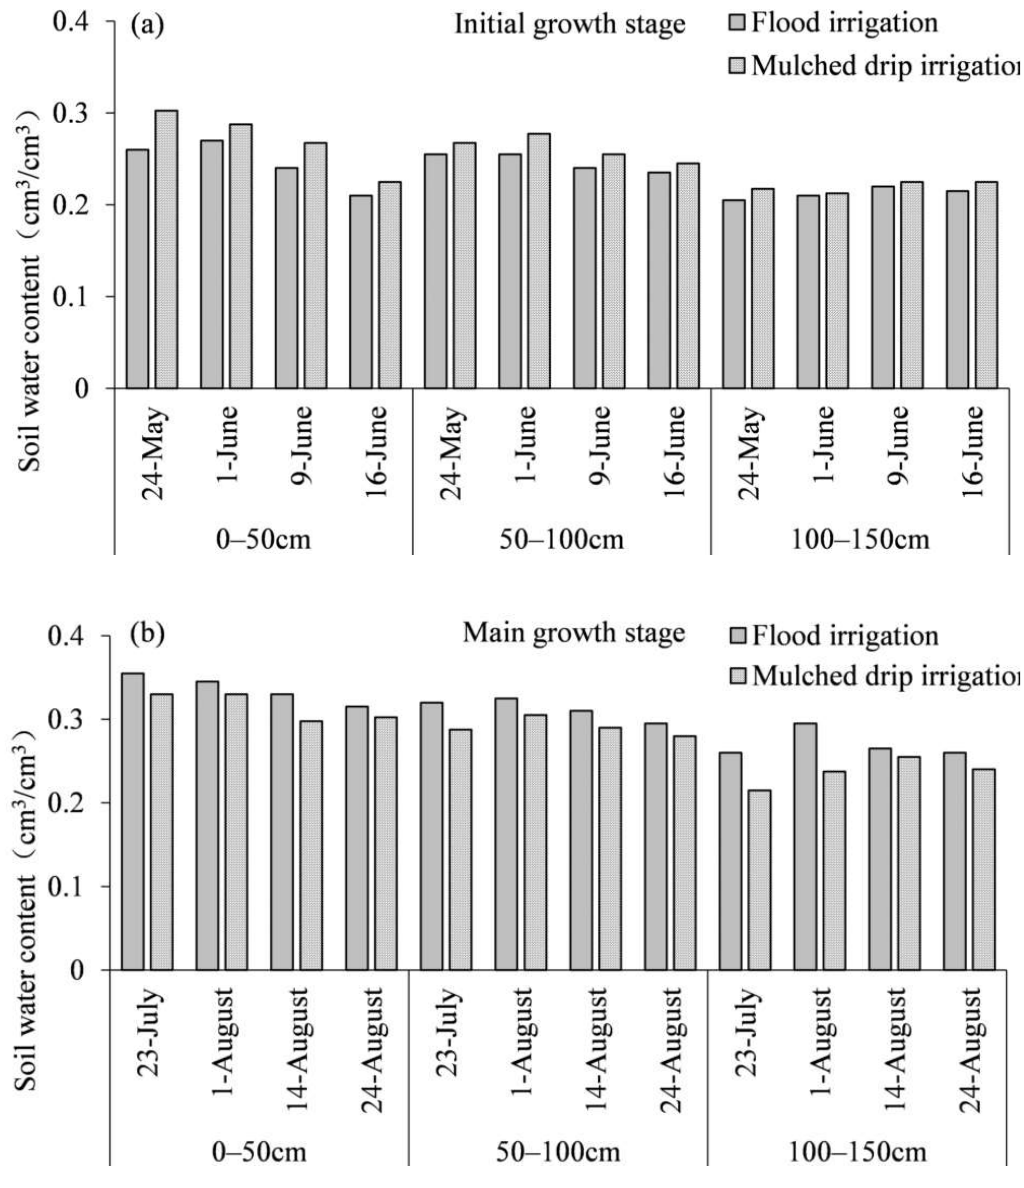
Figure 3. Comparison of soil water content between mulched drip irrigation and flood irrigation.